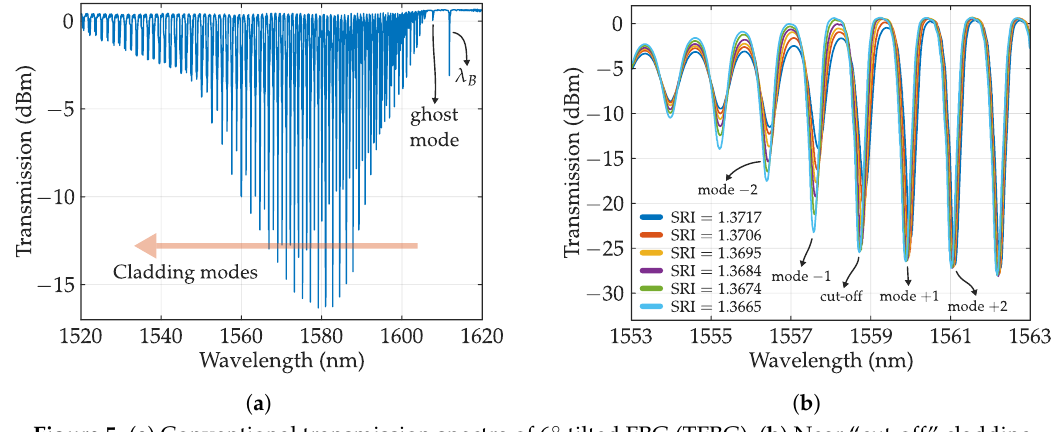
Figure 5. ( a ) Conventional transmission spectra of 6 ◦ tilted FBG (TFBG). ( b ) Near “cut-off” cladding mode resonances with different refractive index (RI) immersions. Both are reproduced from